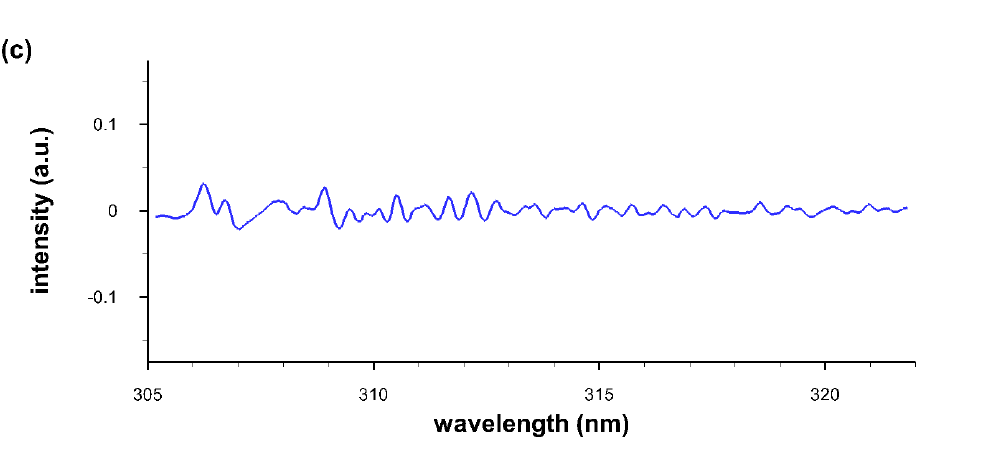
Figure A1. ( a ) Recorded and ( b ) fitted OH spectra. ( c ) Difference of measured and of fitted spectra. Time delay:100 µ s, gate width:50 µ s,